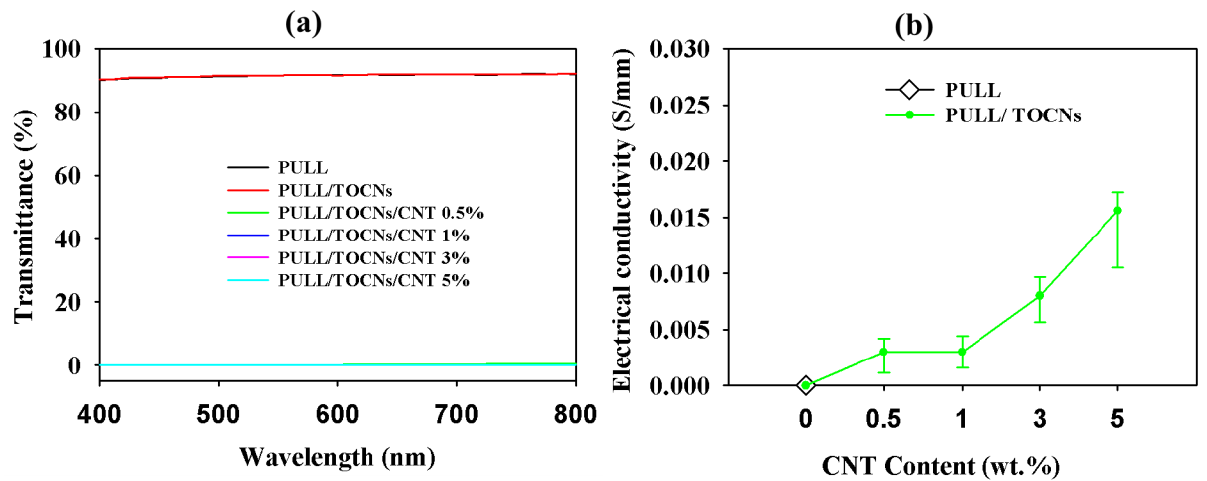
Figure 8. The ( a ) visible light transmittance and ( b ) electrical conductivity of the neat PULL and PULL/TOCNs/CNT nanocomposite films.